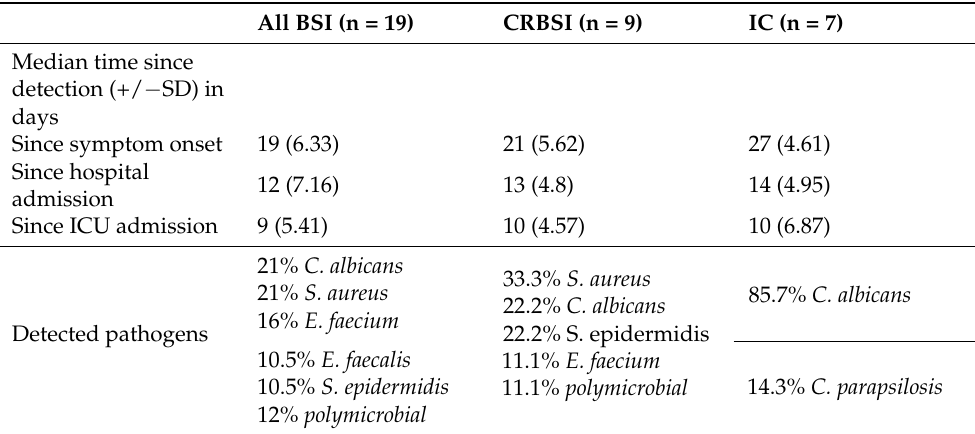
Table 4. Clinical data and pathogens of BSI (blood-stream infection), including CRBSI (catheter- related blood-stream infection) and IC (invasive candidiasis).